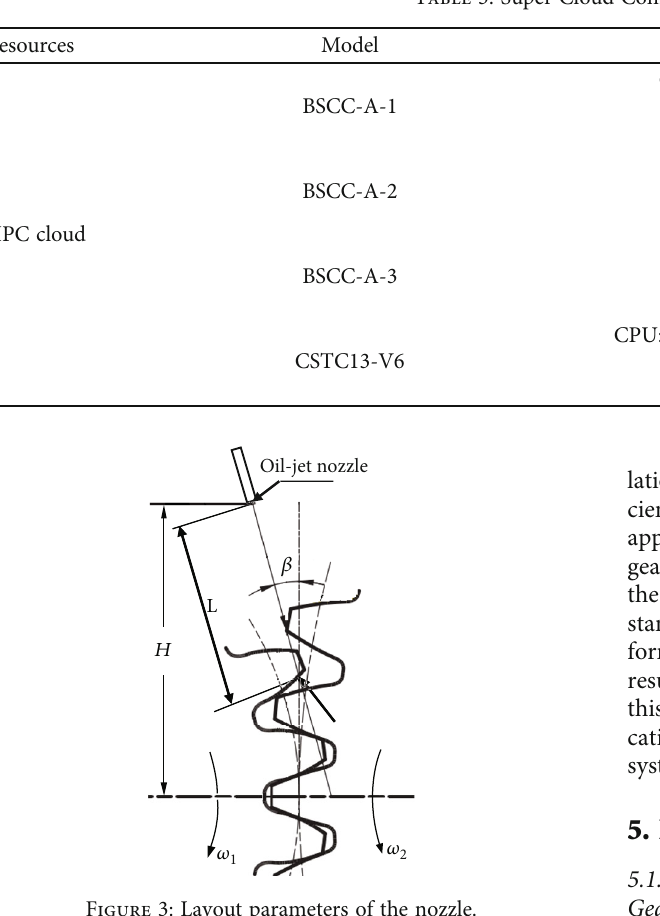
Table 3: Super Cloud Computing Center.